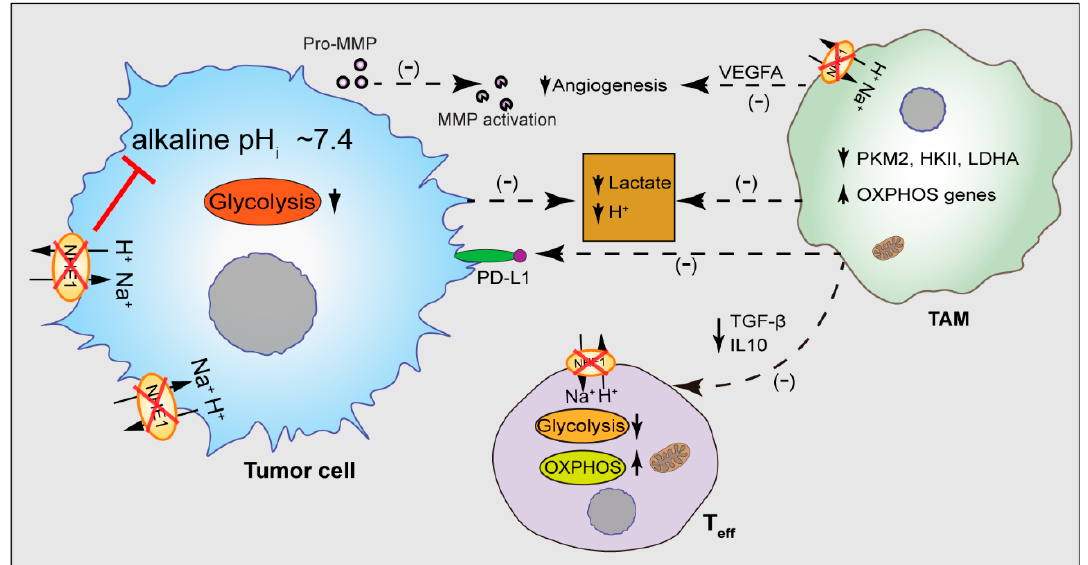
Figure 3. NHE1 blockade rewires TAMs metabolism. Blockade of Na/H exchanger (NHE1) affects tumor progression via multiple mechanisms. NHE1 blockade reduces glycolysis in the tumor cells and the macrophages reducing H + and lactate in the TME. Alteration of acidic pH e reduces tumor angiogenesis by blocking metalloprotease (MMP) activation. Reduced NHE1 activity in the TME reprograms macrophage metabolism by increasing OXPHOS genes while reducing glycolytic genes of the macrophages, resulting in reduced TGF- β and IL10 secretion which increases T cell effector function and reduces regulatory T cells. Reduced PKM2 expression of macrophages leads to reduced PD-L1 expression of the cancer cells. Therefore, blocking NHE1 rewires the metabolism of the TAMs which improves the anti-tumor immunity of the T cells. MMP, matrix metalloproteinase; VEGF, vascular endothelial growth factor; PKM2, pyruvate kinase M2; HKII, hexokinase II; LDHA, lactate dehydrogenase; PD-L1, programmed death-ligand